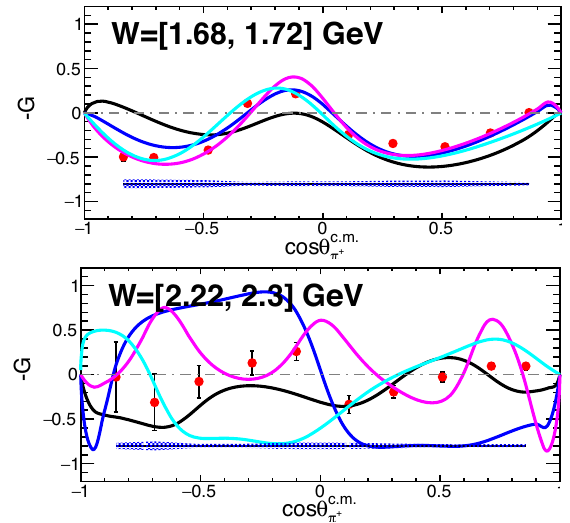
Figure 1. Beam-target polarization observable − G in the γ p → π + n reaction from FROST for two selected energy bins out of 23 (red data points) [11]. The curves are predictions from SAID MA19 (blue) [12], MAID (magenta), GW-Jülich (cyan) [13], and BnGa (black) [14,